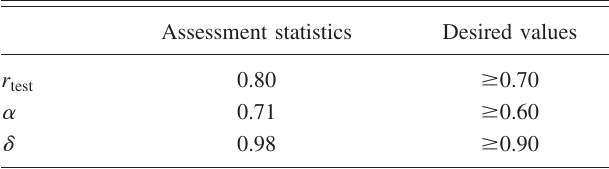
TABLE IV. Assessment analysis: Measured and desired values for the Kuder-Richardson reliability index r test , Cronbach’s (cid:2) and Ferguson’s (cid:3) .